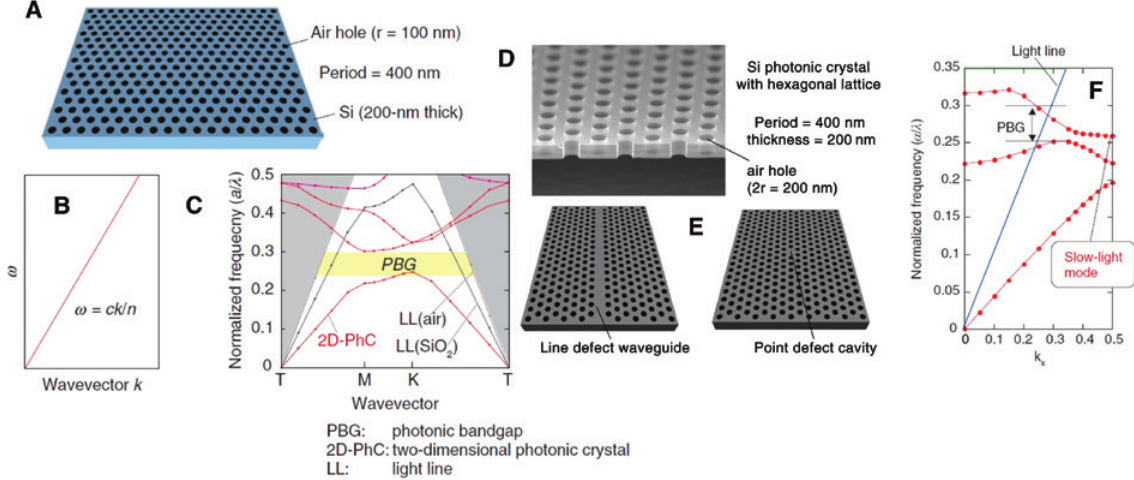
Figure 18: Photonic crystal structures and their optical properties. (A) Schematic diagram of a 2D hexagonal PhC slab with etched air holes fabricated from a SOI wafer. (B) and (C) Light dispersion in con- ventional materials and in the given silicon PhC, respectively. Adapted from [128]. (D) SEM micrograph of a 2D Si PhC slab. (E) Engineered defects in a 2D PhC slab W1 line-defect waveguide (left) and point-defect cavity (right). Adapted from [116]. (F) Light dispersion in a line- defect waveguide in a similar silicon hexagonal air-hole PhC. Adapted from [128].